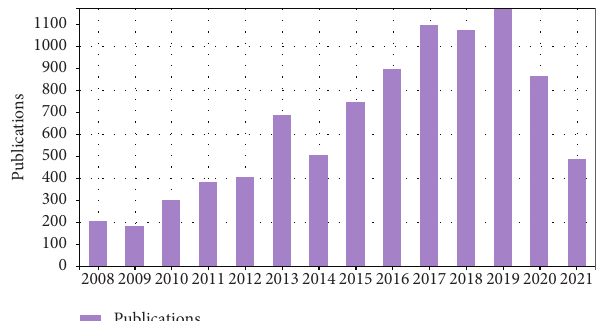
Figure 4: The number of publications on game-based